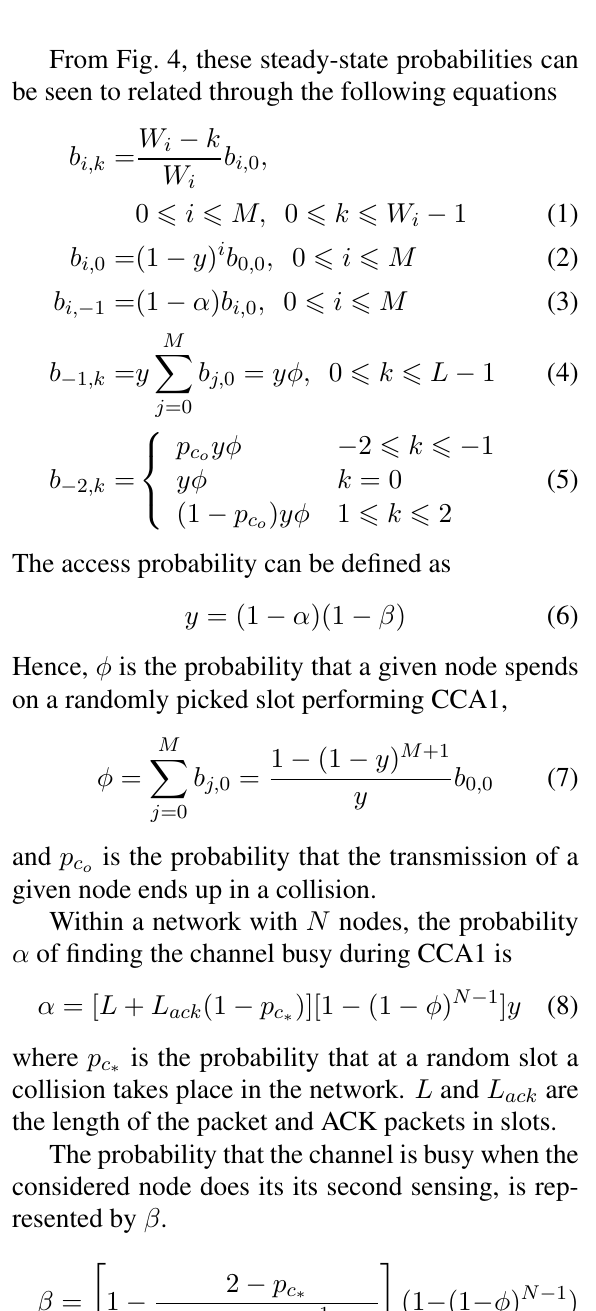
Fig. 4. Markov model for slotted CSMA/CA per